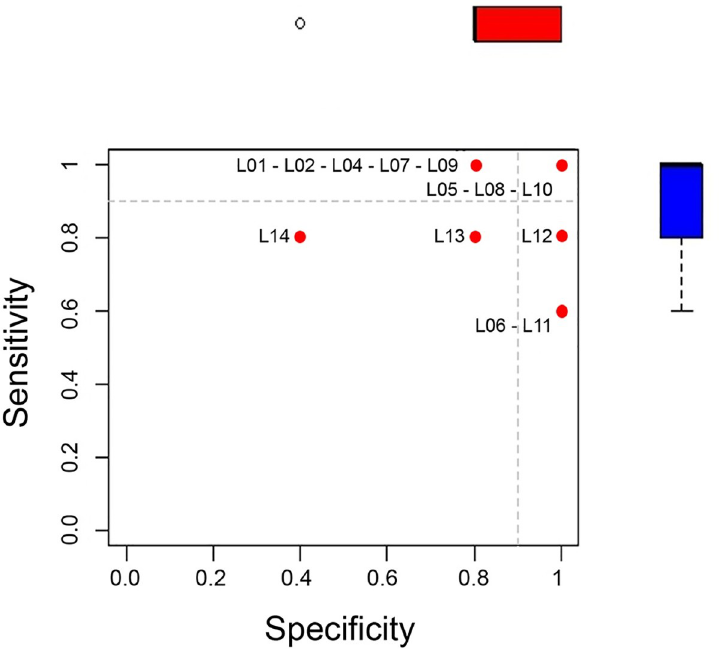
Fig 1. Scatter plot of sensitivity by specificity of DFA PT results. The sensitivity (y-axis) and the specificity (x-axis) are shown for each laboratory (red dot and laboratory ID). Laboratories 05, 08 and 10 correctly identified all samples and can be found in the upper right corner. The box-plots displayed in the margin represent the data distribution of the sensitivity (blue) and specificity (red).